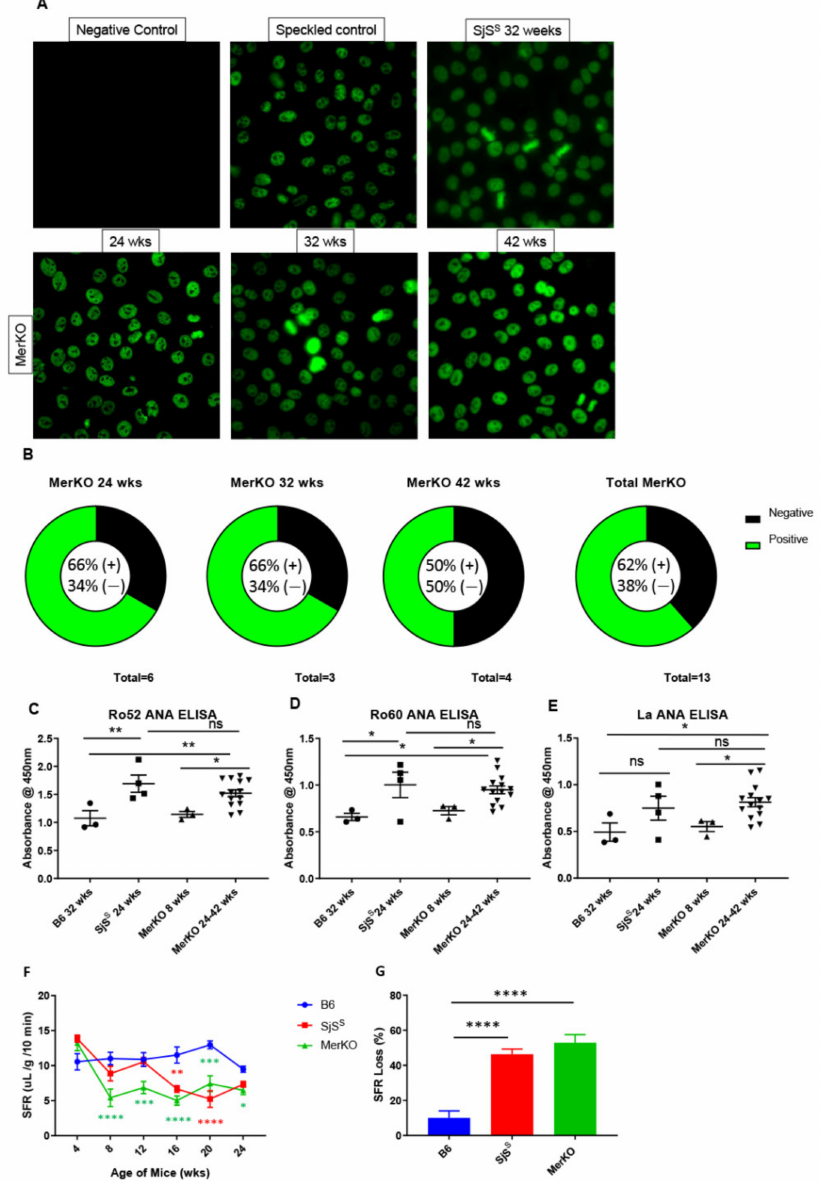
Figure 2. MerKO mice develop speckled ANA, anti-Ro52, Ro60, and La, and show comparable SFR loss to SjS S mice with earlier onset. ( A ) Sera from MerKO (n = 13) mice was diluted 1:40 and incubated with Hep-2 slides followed by AF488 mouse secondary antibody and observation under a fluorescence microscope at 400 × . ( B ) Graphs display the frequency of speckled staining patterns in MerKO sera at 24, 32, and 42 weeks of age. ( C – E ) B6 (n = 4), SjS S (n = 4), and MerKO (n = 14) sera was diluted 1:20 and assayed for Ro52 ( C ), Ro60 ( D ), and La ( E ) antibodies via ELISA. ( F ) Saliva was collected from B6 (n = 8), SjS S (n = 7), and MerKO (n = 7) mice from 4 to 24 weeks of age. Saliva data were reported as SFR in µ L/gram/10min. ( G ) The percentage of the loss of SFR between the 4-week and 24-week time points was calculated for B6, SjS S , and MerKO. The statistical significance was calculated by one-way ANOVA or two-tailed unpaired t-tests where error bars indicate SEM * p < 0.05, ** p < 0.01, *** p < 0.001, and **** p